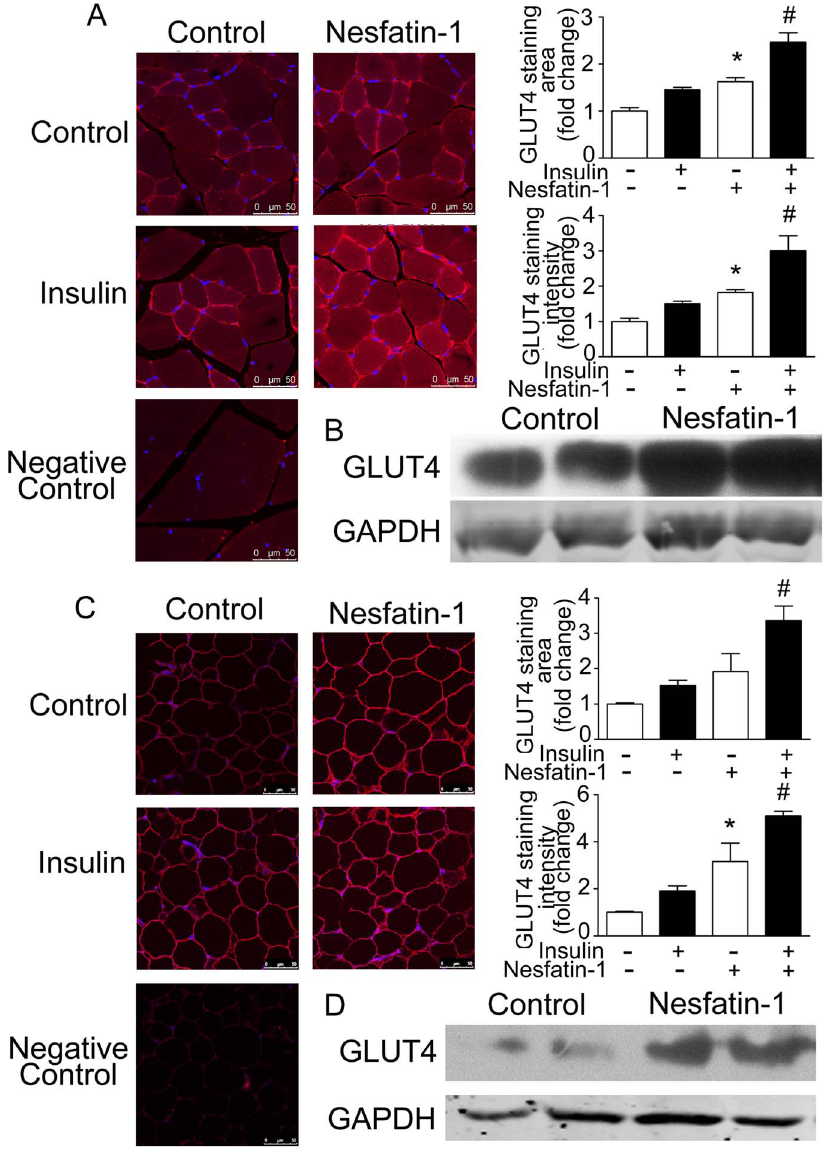
Figure 5. Effects of peripheral nesfatin-1 infusion on GLUT 4 in NCD mice. (A, C) Immunofluorescent staining for GLUT4. Immunofluorescent staining was performed using specific antibody against GLUT4 (red) in skeletal muscle (A) and adipose tissue (C). Nuclei were stained with Hoechst dye. Controls include substituting primary antibodies with mouse IgG. Signal intensity of cytoplasm membrane GLUT4 immunoreactivity was quantified and normalized to the basal control, Data are expressed as mean 6 SEM. * P , 0.05 vs. control, # P , 0.05 vs. insulin stimulation without nesfatin-1 treatment. (B, D) Western blotting for GLUT4. Western blot was performed using specific antibody against GLUT4 in skeletal muscle (B) and adipose tissue (D). GAPDH was used as the internal control. Shown were representative results from six individual experiments.